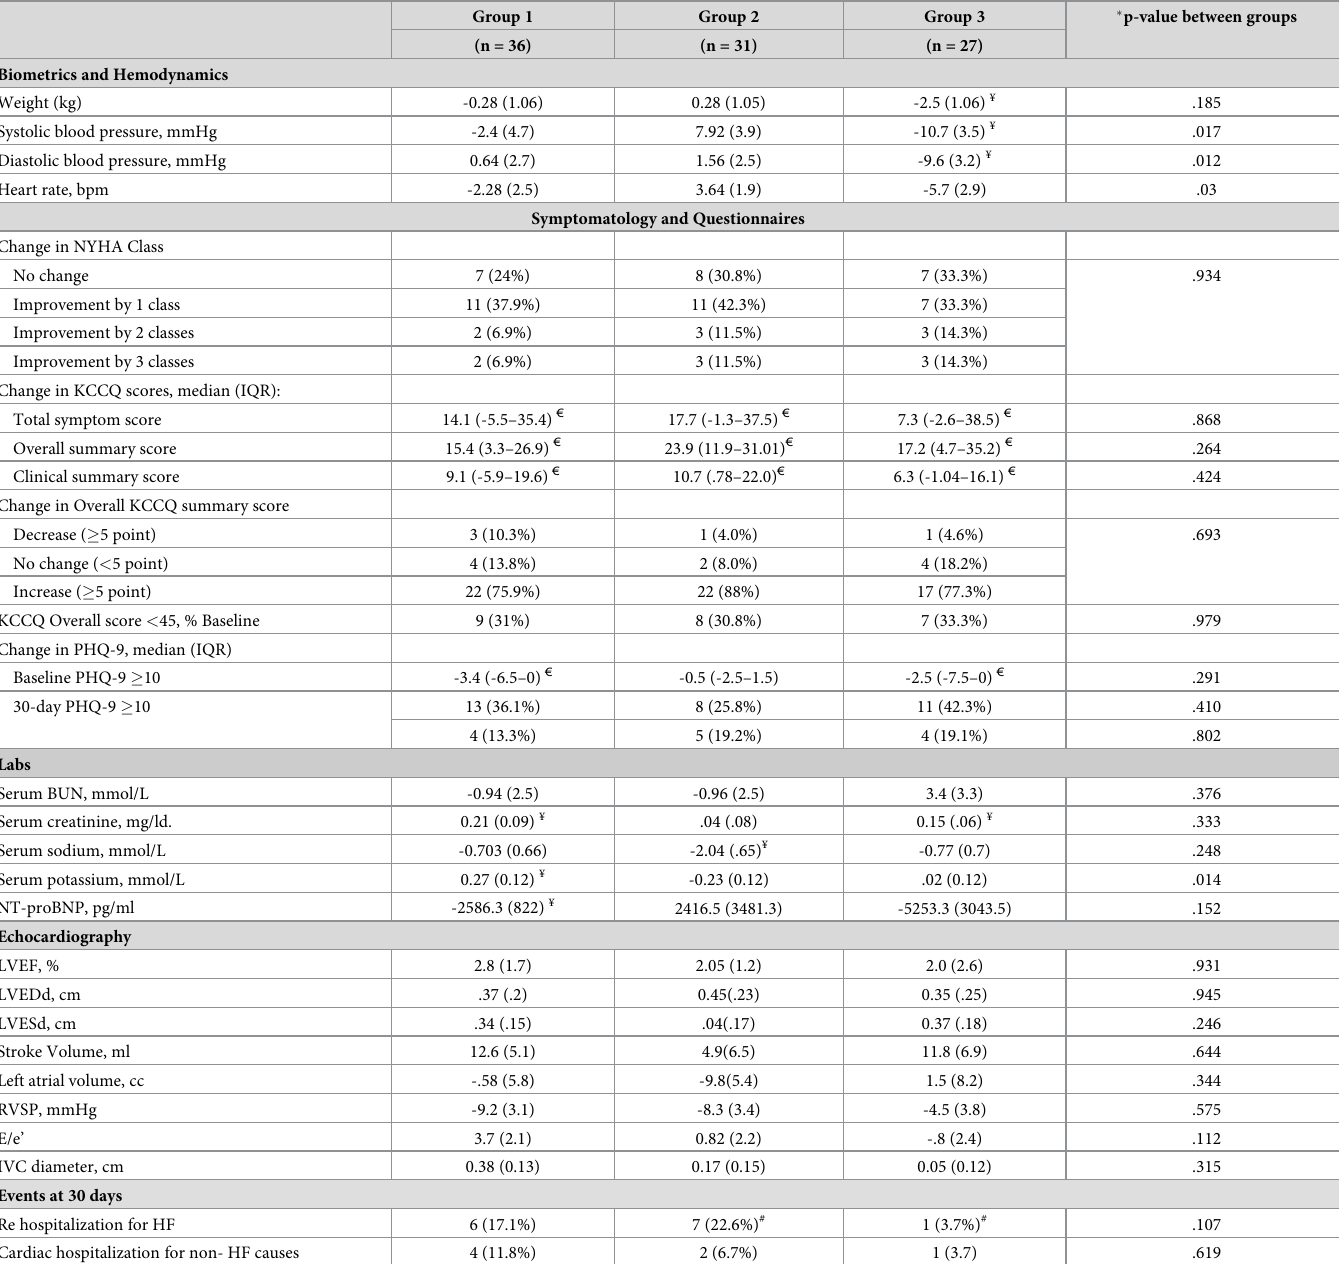
Table 3. Changes in study outcome at 30 days compared to baseline categorized by treatment intervention